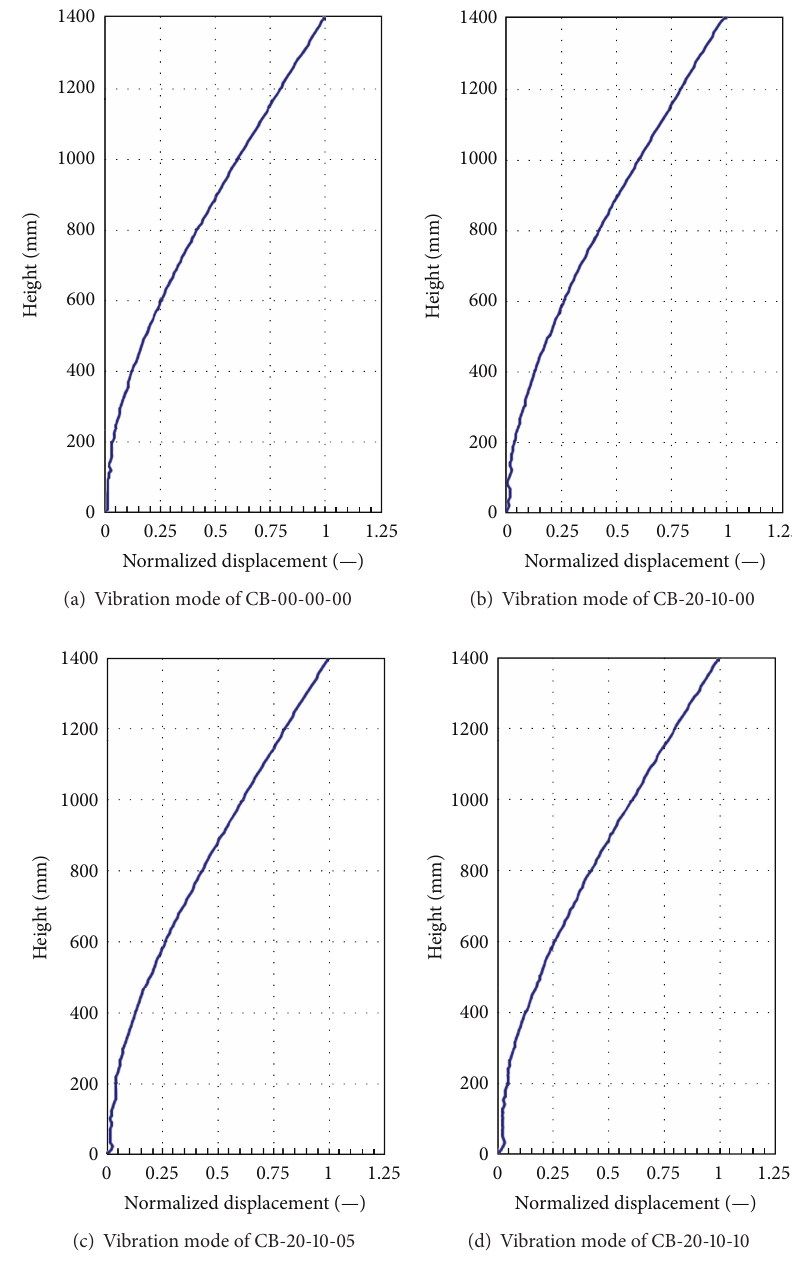
Figure 11: The remarkable vibration mode of various test